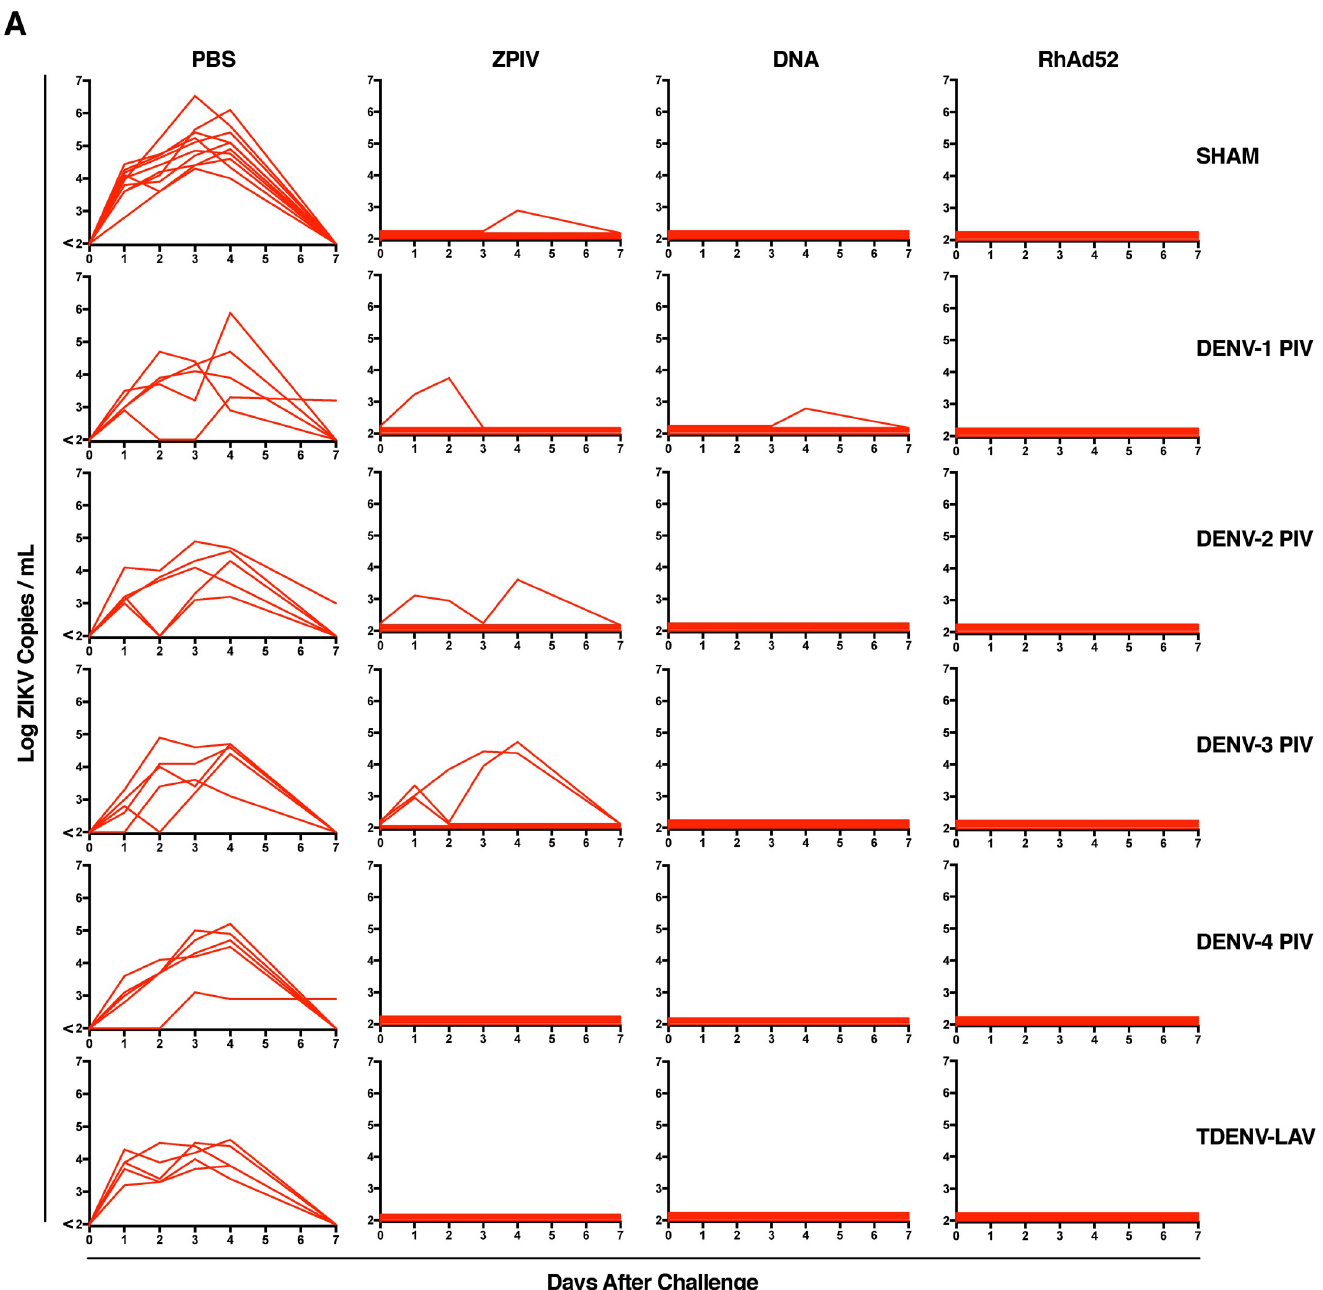
Fig 4. Previous DENV-Immunity induced by vaccination does not enhance ZIKV disease in mice. Mice were immunized intramuscularly (i.m.) on weeks 0 with 1 μ g of each DENV serotype of the purified inactivated vaccine (DENV-PIV) or 10 2 PFU of the live attenuated tetravalent DENV vaccine (TDENV-LAV) and vaccinated on weeks 4 and 8 with 50 μ g of the DNA-M.ENV vaccine and 1 μ g of the purified inactivated ZIKV (ZPIV). Mice received a single immunization with 10 9 vp of the RhAd52-M.ENV vaccine. Mice were challenged i.v. with 10 2 PFU ZIKV-BR 4 weeks after DNA-M.ENV and ZPIV vaccination and 8 weeks after RhAd52-M. ENV vaccination. (A) ZIKV mRNA viral loads in serum. Data is representative of one experiment with 5–10 animals per group. Each line represents an individual mouse.